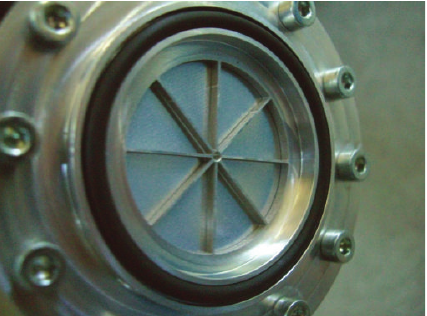
Figure 9: Vacuum-separating window in the extraction guides. The foil must guarantee the vacuum tightness but also it should resist to an overpressure of 1.5 bar max in both directions in case of eventual fast heating of the source. Such overpressure is limited using two safety valves. The window is made with 2 aluminum half pieces milled by electrocutting reinforced by letting ribs 0.25 mm thick. Between these two parts a titanium foil 0.015 mm thick and 2 o’rings are inserted. The assembly is bolted. The window assembly had been tested with success under vacuum and under 5 bar pressure.